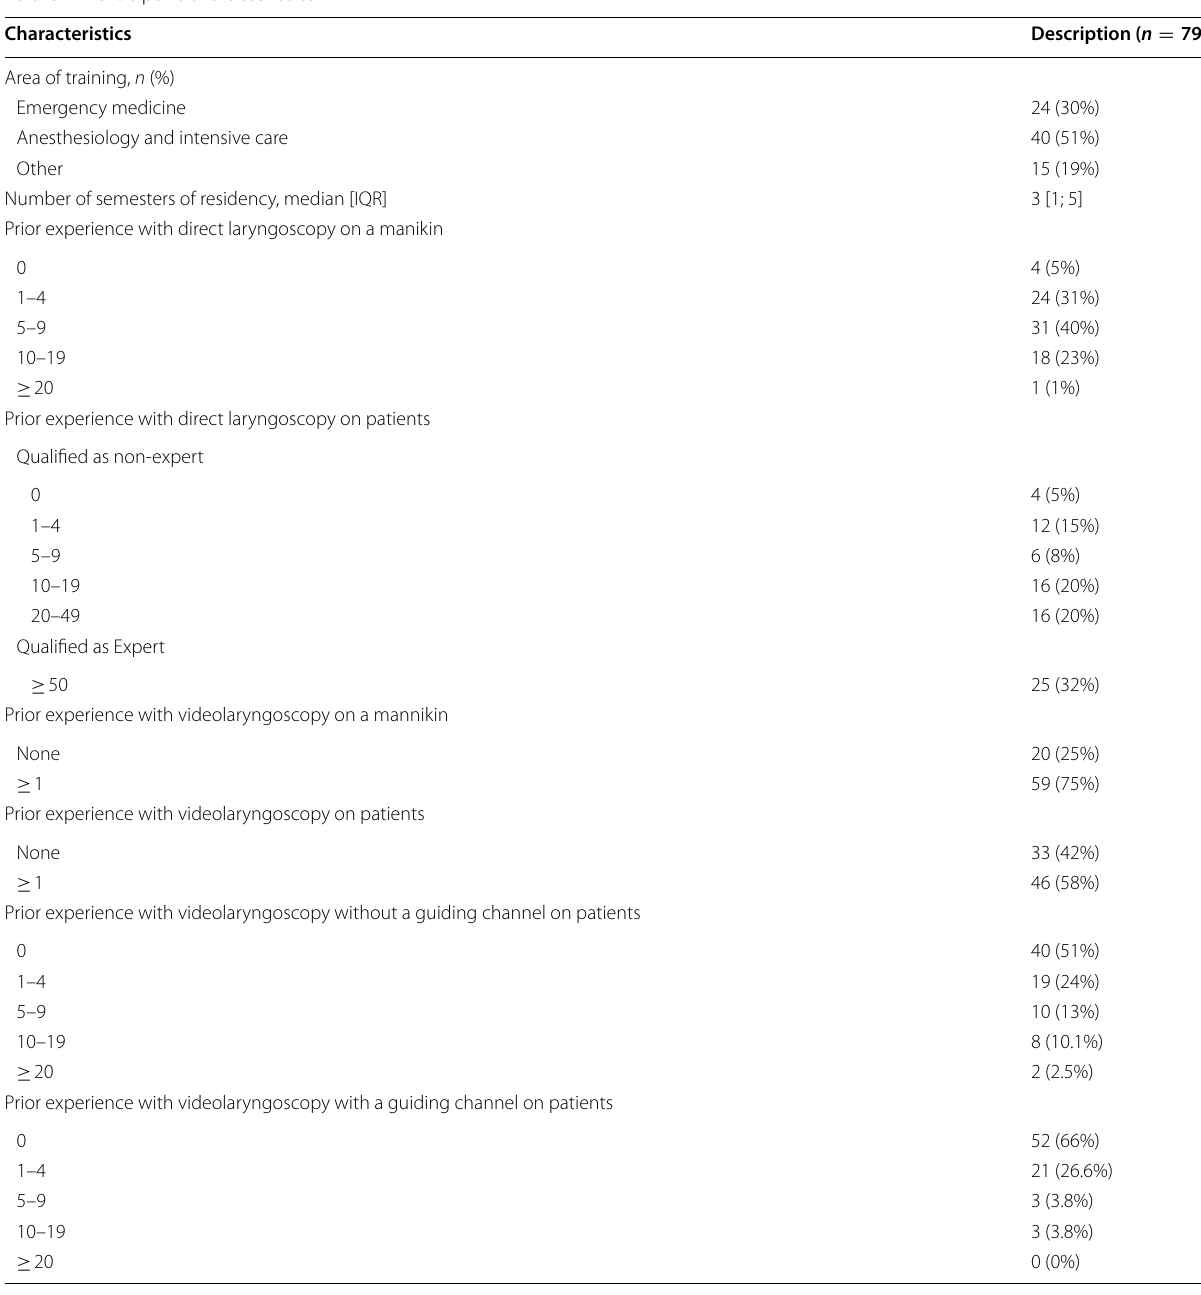
Table 1 Participant